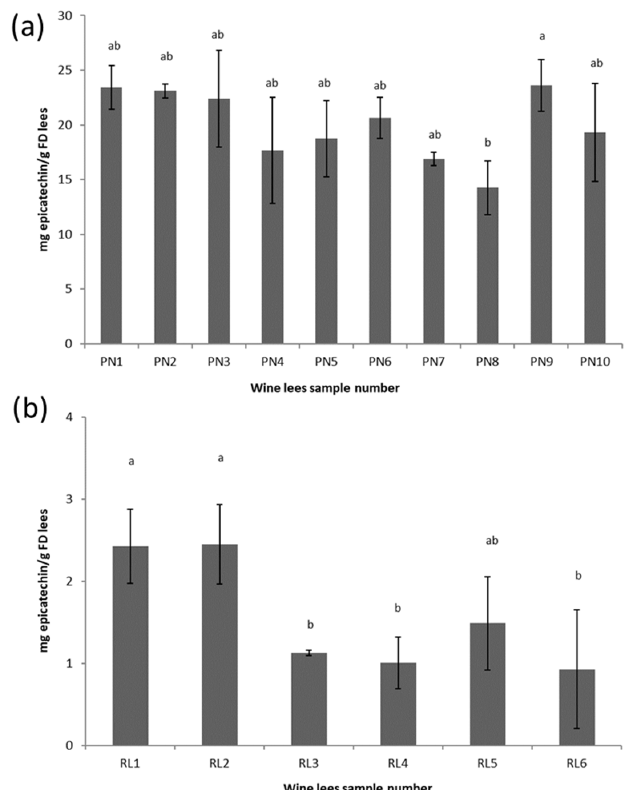
Figure 2. Total tannin content (mg epicatechin equivalent/g DM lees) of PN ( a ) and RL ( b ) dry-matter lees. Means that do not share the same letter (a–c) are significantly different ( p < 0.05). Error bars represent the standard deviation of replicate samples (n = 3).